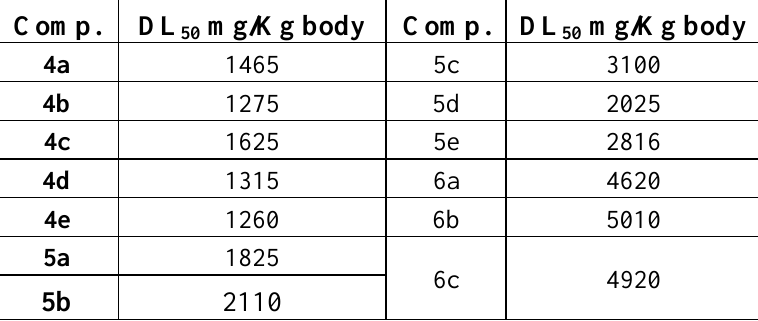
Table 2. The DL50 values of the tested compounds.